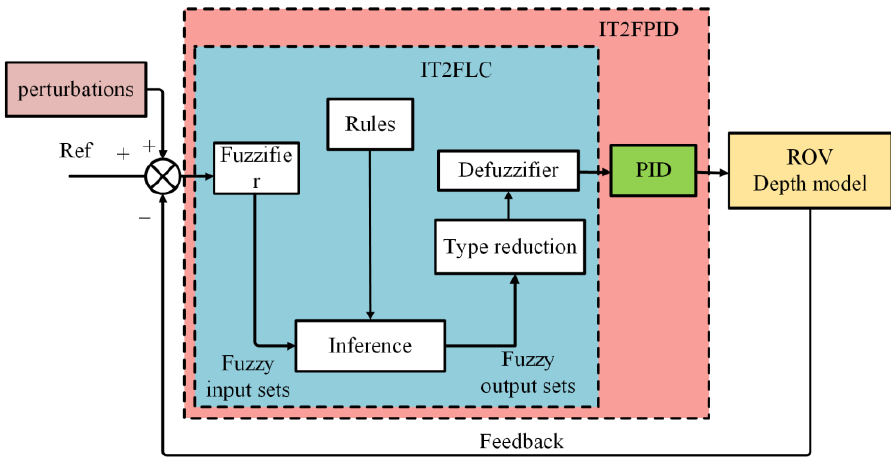
Figure 4. Control schemes for the interval type-2 fuzzy proportional integral derivative (IT2FPID).